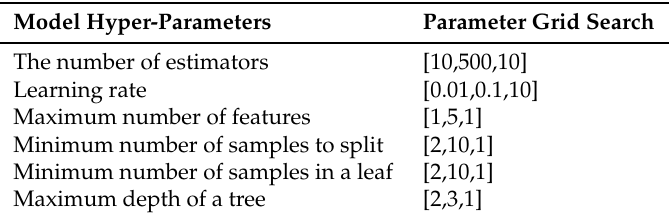
Table 2. Model hyper-parameters tested for the randomized grid search with five-fold cross validation. In the square bracket for grid search, the first integer number indicates the number to start, the second number to stop, and the last number the